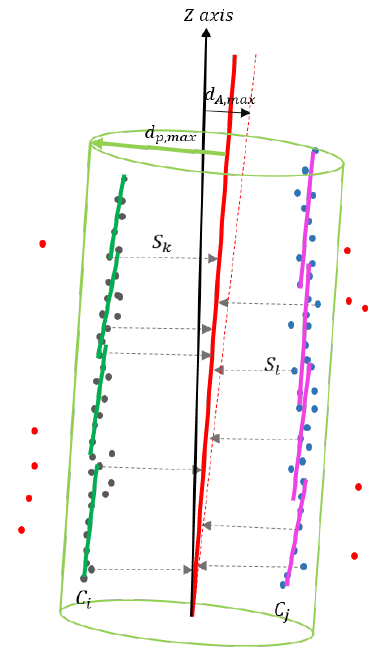
Figure 4. The stopping criterion for clustering the segments. The green lines represent the segments in cluster C i and the magenta lines show the segments in cluster C j , respectively. The red line is the line fitted to both clusters’ points. The red points outside the cylinder have projected distance greater than d p,max